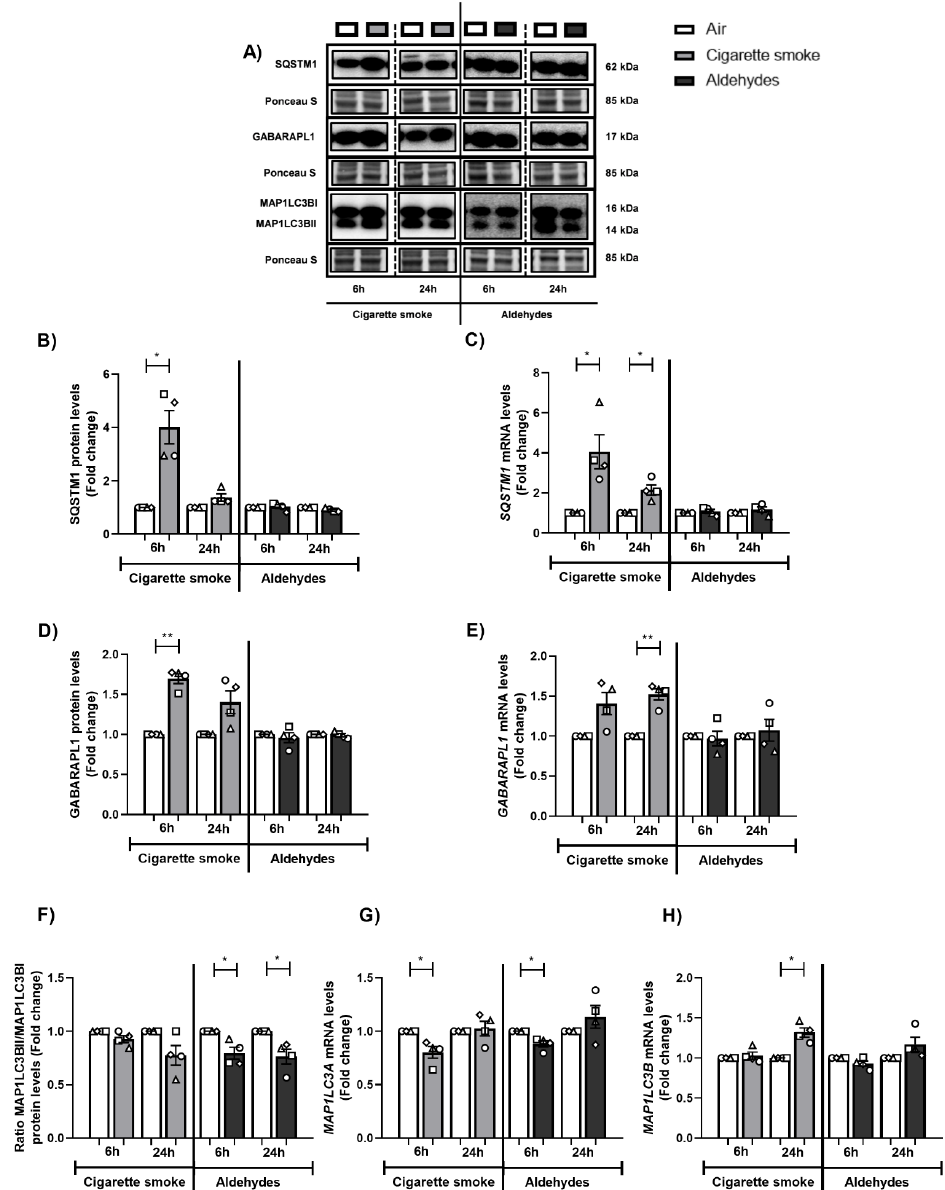
Figure 3. Changes in the abundance of autophagic components in response to exposure to CS or aldehydes. Differentiated human primary bronchial epithelial cells (PBEC) from non-COPD subjects ( n = 4 donors) were exposed to smoke of one Marlboro Red cigarette (CS), or a mixture of acetaldehyde, acrolein, and formaldehyde (at concentrations equivalent to one cigarette), or air (control), in a continuous flow system using a puff-like exposure protocol. Following recovery for 6 h or 24 h, whole cell lysates were harvested for analysis of the ( A , B , D , F ) protein and ( C , E , G , H ) transcript abundance of constituents associated with autophagy, respectively SQSTM1, GABARAPL1, ratio MAP1LC3BII/I, and MAP1LC3A and MAP1LC3B. Representative Western blot images are shown of one replicate of one donor per experiment, reflective of the changes in all donors as quantified in the corresponding graph. Data are presented as mean fold change compared to air control ± s.e.m. The mean values from biological triplicates per independent donor are represented by open circles, triangles, squares, or diamonds. Statistical differences between CS vs. air and the mixture of aldehydes vs. air were tested using a two-tailed paired parametric t -test. Statistical significance is indicated as * p < 0.05 and ** p < 0.01 vs. air